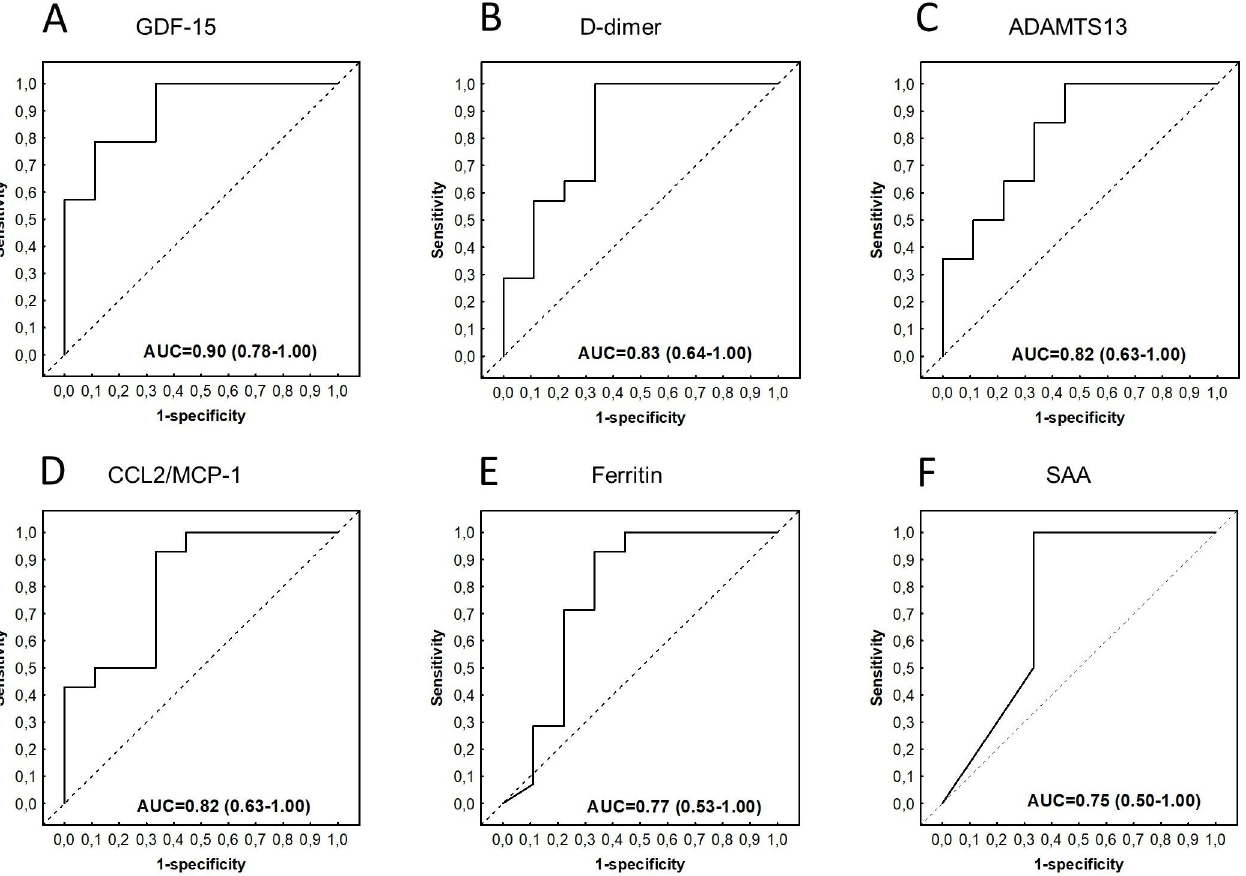
Fig 6. Receiver operator characteristic (ROC) curves showing the accuracies of baseline serum GDF-15 (A), D-dimer (B), ADAMTS13 (C), CCL2/MCP-1 (D), Ferritin (E), and SAA (F) in indicating stroke among children diagnosed with TBM. ROC curves for analytes with AUC � 0.75 are shown.